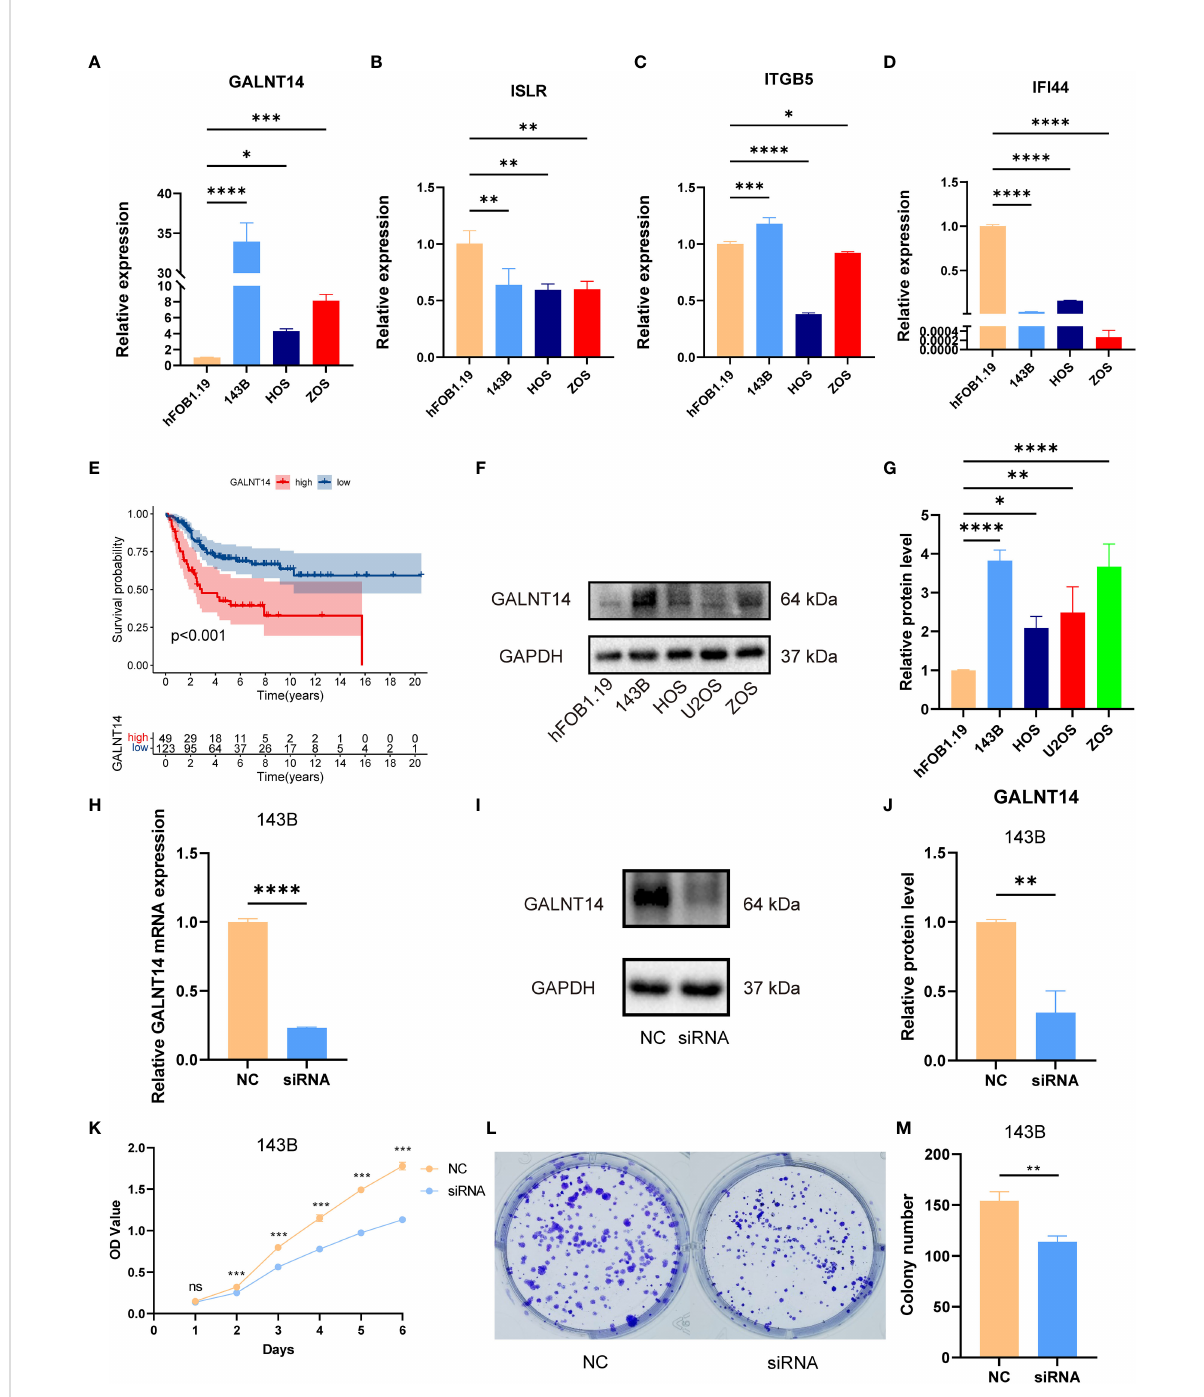
FIGURE 8 The expression of signature genes in OS and the effects of GALNT14 in OS. (A – D) The mRNA expression of GALNT14, ISLR, ITTGB5, and IFI44 was examined by RT-qPCR in hFOB 1.19 and osteosarcoma cell lines. (E) Kaplan – Meier curve of the expression level of GALNT14 on OS. (F) The protein expression of GALNT14 was measured by western blot in hFOB 1.19 and osteosarcoma cell lines. (G) The protein level of GALNT14 was quanti fi ed by the Image J software. (H) Knockdown of GALNT14 with siRNA in 143B cells was con fi rmed by RT-qPCR. (I) Knockdown of GALNT14 with siRNA in 143B cells was con fi rmed by western blot. (J) The protein level of GALNT14 was quanti fi ed by the Image J software. (K) Growth curves of cells were examined by CCK-8 assays after the knockdown of GALNT14 in 143B cells. (L) Colony formation assay was detected after the knockdown of GALNT14 in 143B cells. (M) Knockdown of GALNT14 inhibited proliferation of osteosarcoma cells 143B according to colony formation assay. ns, no signi fi cance,*p < 0.05, **p < 0.01, ***p < 0.001, ****p <